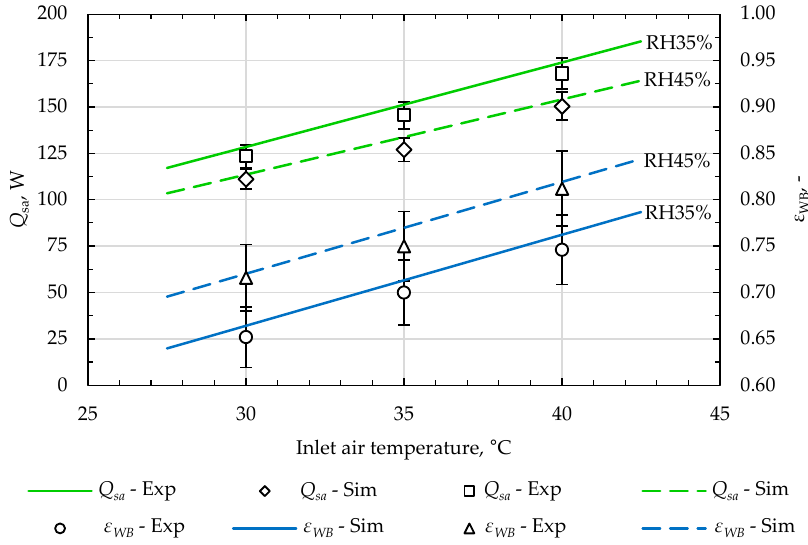
Figure 5. Comparison between simulation results and experimental data (impact of inlet air tempera- ture on cooling capacity and wet-bulb effectiveness).